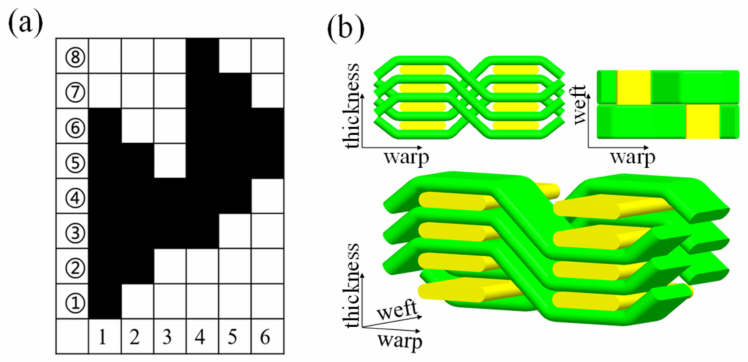
Figure 1. Weave structure design process for 3DPPAI fabric design: ( a ) weave design; ( b ) 3D graphical representation of the woven